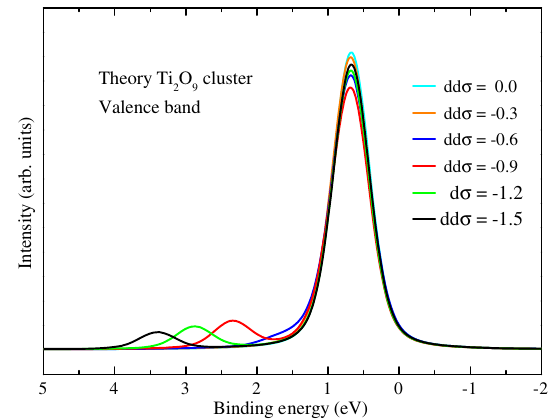
FIG. 7. Calculated valence-band photoemission spectra of Ti 2 O 3 using the Ti 2 O 9 cluster for several values of the inter-Ti hopping dd σ